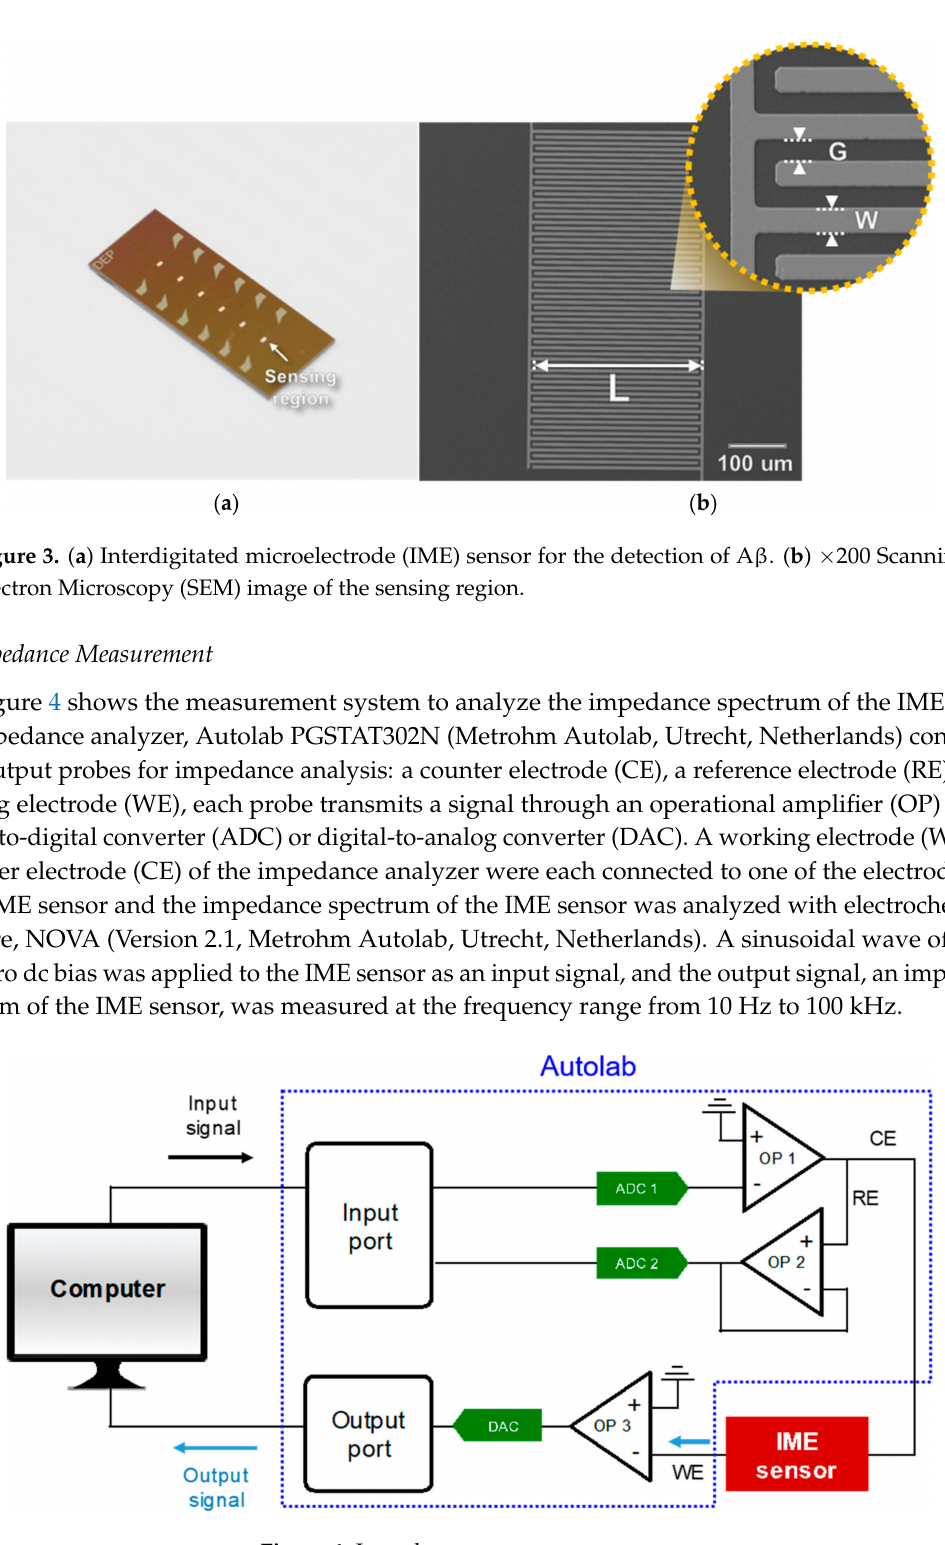
Figure 4. Impedance measurement